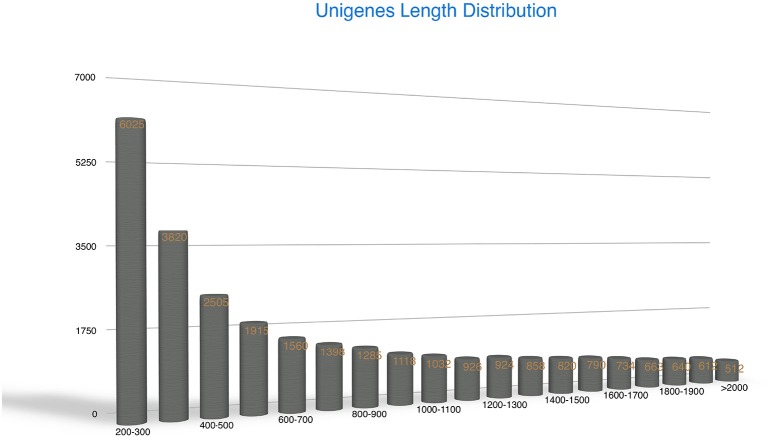
Random distribution of the assembled unigenes. The x-axis indicates the length of the unigenes. The y-axis indicates the number of unigenes.